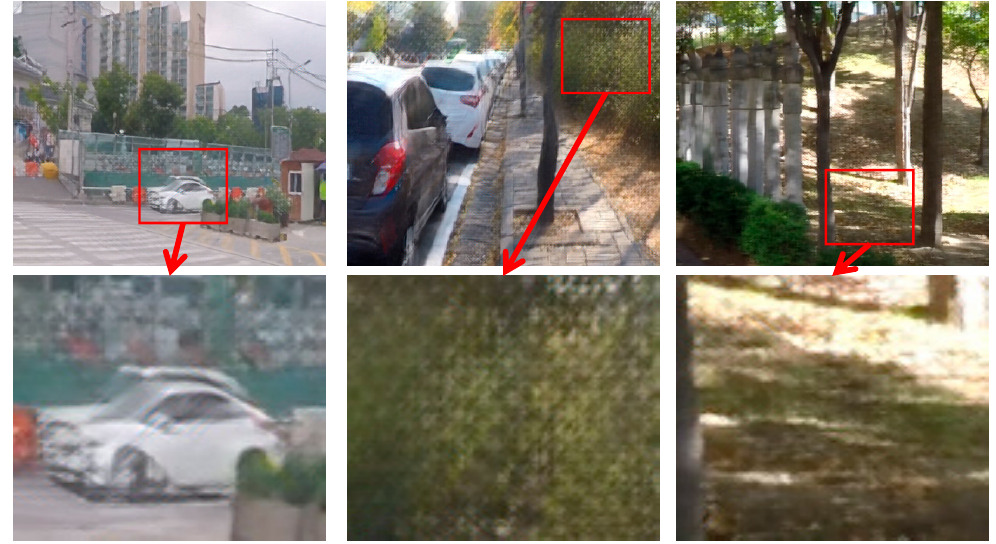
Figure 9. Extending part of example images.